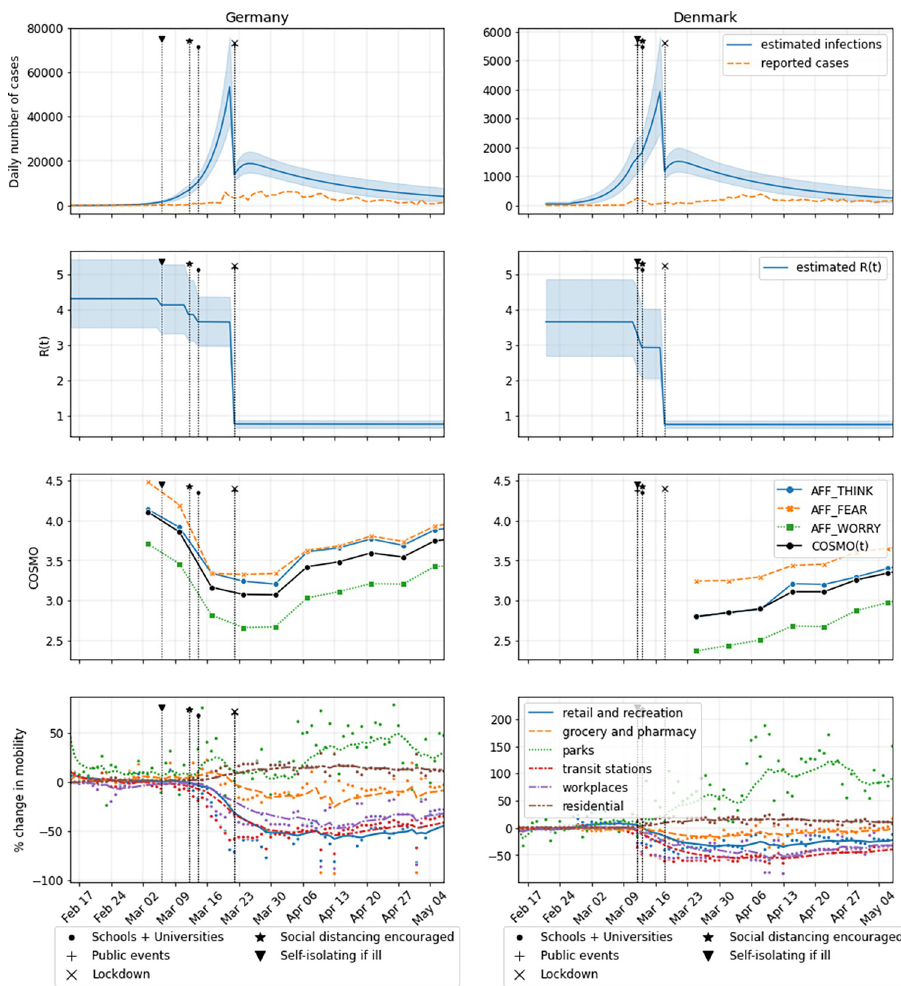
Fig 2. Data available for Germany and Denmark from February 15th to early of May 2020. In the first two rows, estimates for daily infections [4] and reproduction number R are presented as time varying means and standard deviations. Third row shows three selected variables from the AFFECT group in the COSMO surveys (see S1 Text in Supplementary Information for more details; higher values indicate that COVID-19 was seen as something one does not think about all the time, rather not terrifying, and something not to worry about); their weighted mean (derived from PCA) labeled as COSMO(t) is used in the model inversion. The last row presents the scatter plots of the Google mobility report overlaid with lines marking the 7-day weighted moving averages, where the mean of the blue "retail and recreation" variable is used in the model inversion. corresponding fit of the model as lines with the same color scheme. The bottom row shows posterior distributions for model parameters of interest along with the priors (in grey) placed on those parameters. While in Bayesian terms, the coupling strength γ is well identified by the data of both Denmark and Germany, Γ , c are identified strongly only for data from Germany.